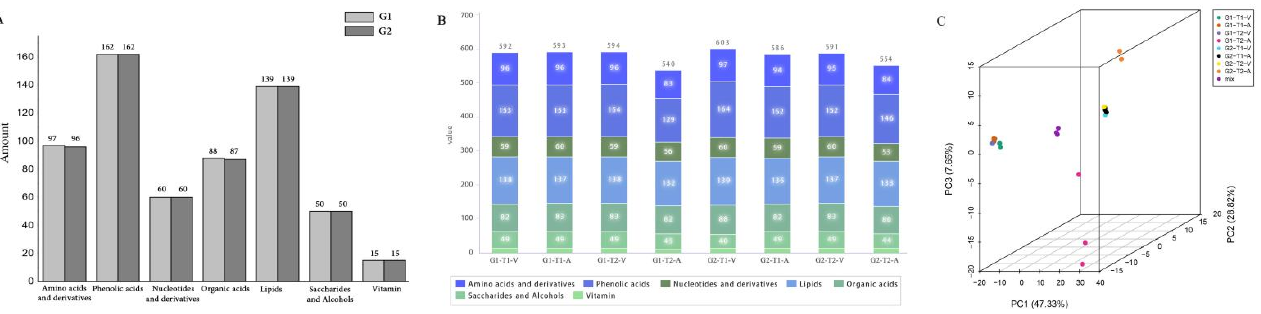
Figure 2. The effects of storage methods on the primary metabolites of G1 and G2. ( A ) The amount of each kind of primary metabolite in G1 and G2. ( B ) Stacked graphs of the amounts of various primary metabolites in the different storage methods of G1 and G2. ( C ) PCA on the effects of storage methods on the primary metabolites of G1 and G2.